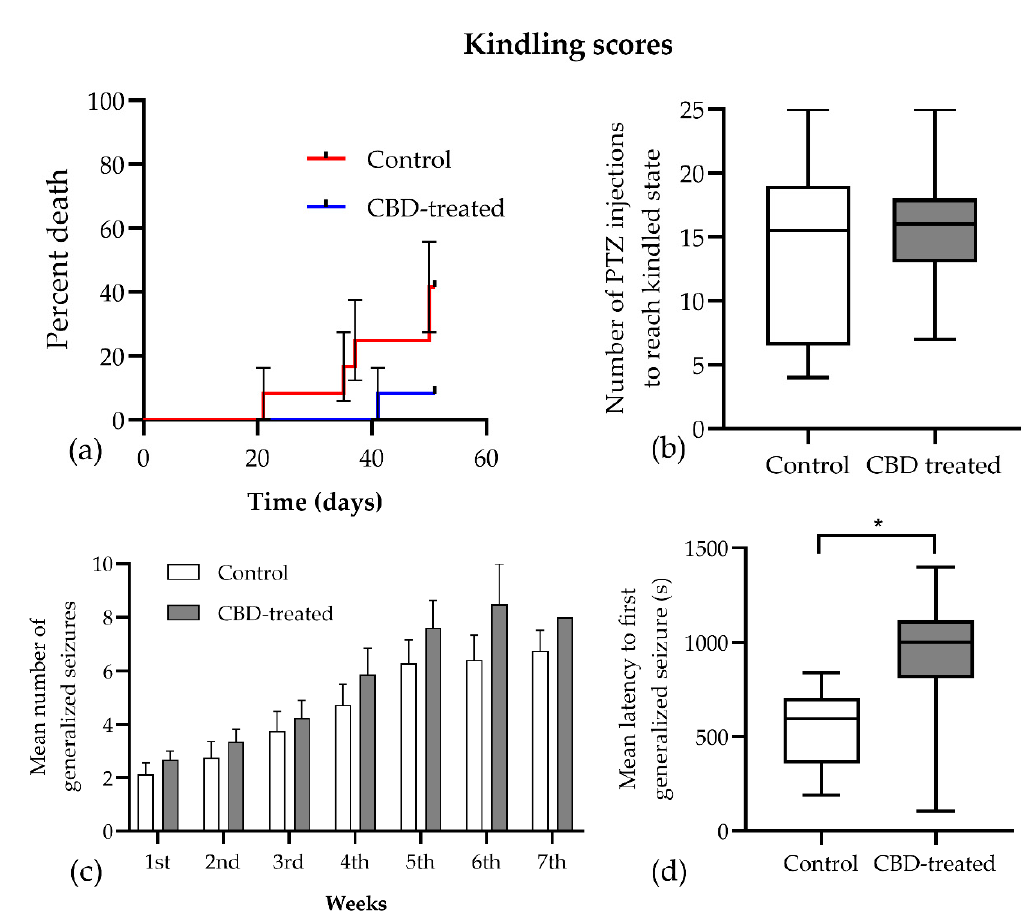
Figure 3. Effects of chronic CBD treatment on the kindling scores induced by pentylenetetrazole in rats. The development of kindling was characterized by the following parameters: ( a ) mortality rate due to generalized seizures, ( b ) the total number of PTZ injections to reach the kindled state, ( c ) the number of generalized seizures, and ( d ) the latency to the first generalized seizure. Data are expressed as mean ± SEM in the bar graph and as mean (solid line) with the range in the floating bar graphs; * p < 0.05 vs. control.